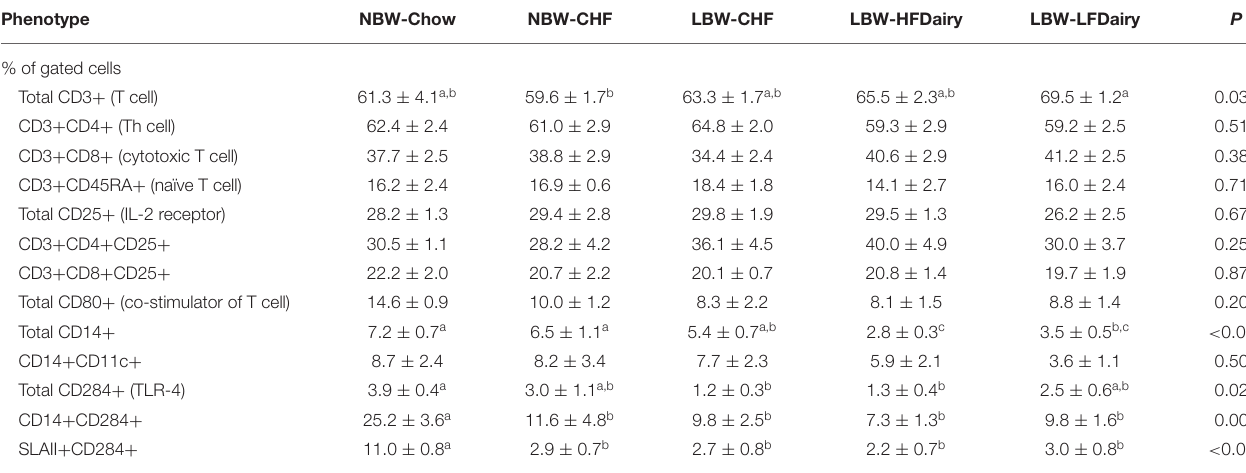
TABLE 3 | PBMCs population of NBW and LBW swine fed different experimental diets.